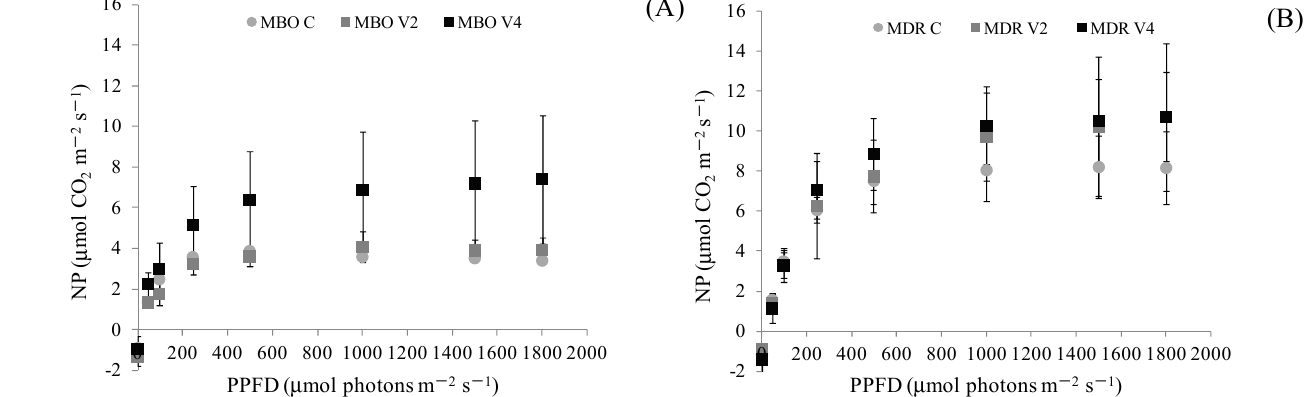
Figure 1. Light response curves of leaf net photosynthesis (NP) to increasing white light intensity in plants of Ranunculus asiaticus L. hybrids MBO ( A ) and MDR ( B ), obtained by three preparation procedures of tuberous roots, only rehydration (Control, C), rehydration plus vernalization for 2 weeks (V2), rehydration plus vernalization for 4 weeks (V4). Plants at vegetative phase (Week 8 from planting). Measurement conditions in the leaf chamber: 20 °C, RH 67%, 470 ppm CO 2 concentration. Mean values ± Standard errors; n = 3.